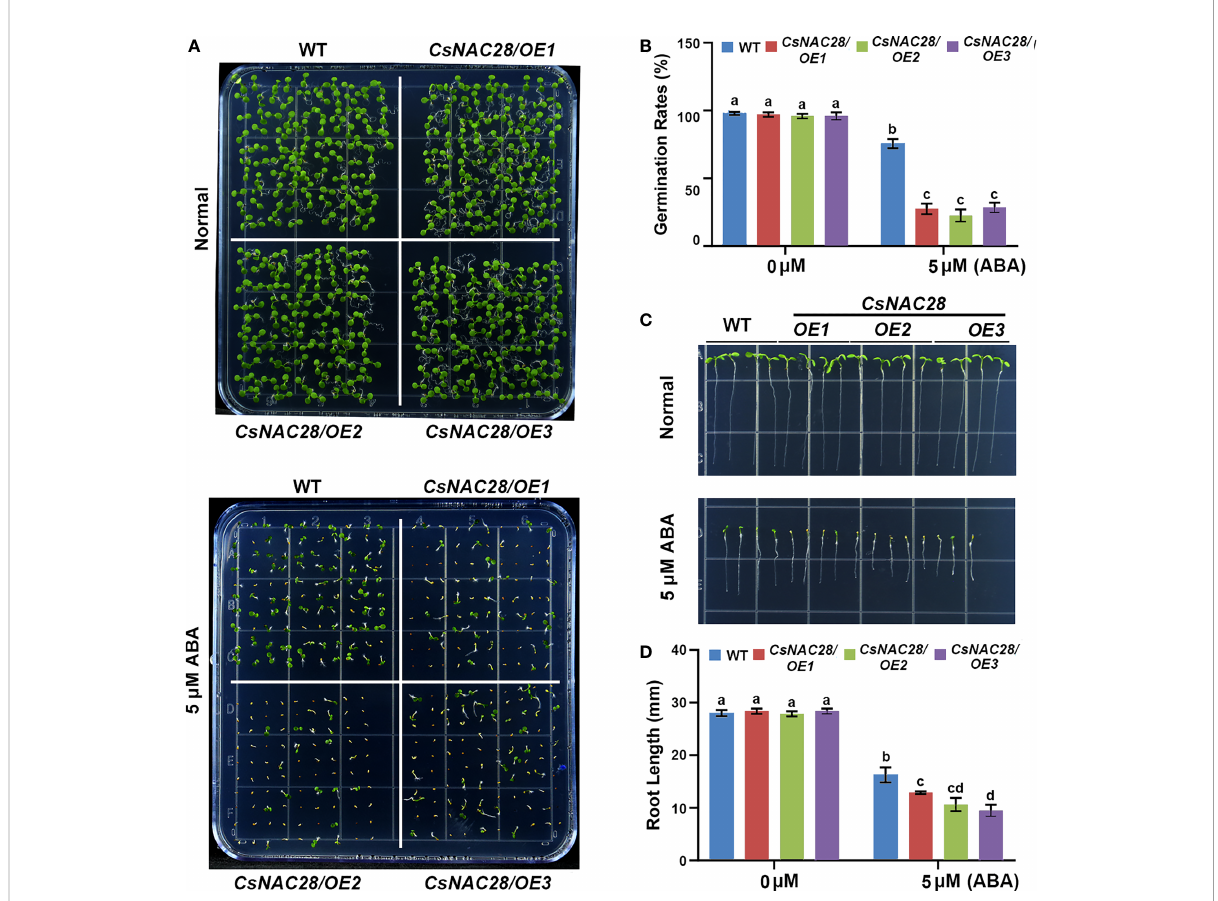
FIGURE 7 Overexpression of CsNAC28 increases ABA sensitivity in transgenic Arabidopsis. (A) Germination assays for each lines under different concentrations of ABA treatments. (B) Germination percentage of each line under different concentrations of ABA treatments. (C) Root length assays for different lines under different concentrations of ABA treatments. (D) Quanti fi cation of root length under different concentrations of ABA